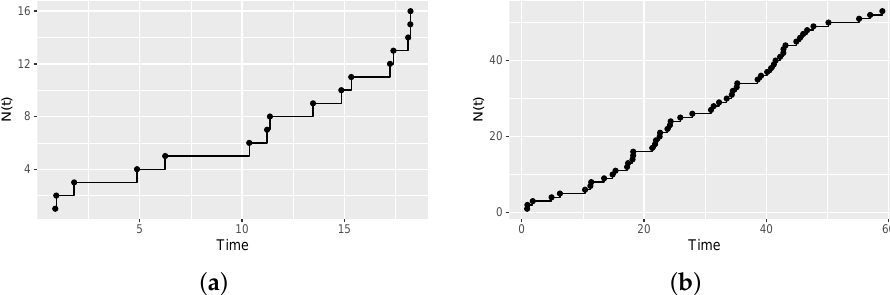
Figure 8. Simulation of a Cox process with Folded Normal intensity function of parameters µ = 15, σ 2 = 169 and with covariance function k Z ( h ) = 169 · I { 0 } ( h ) for T = 20 ( a ) and T = 60 ( b